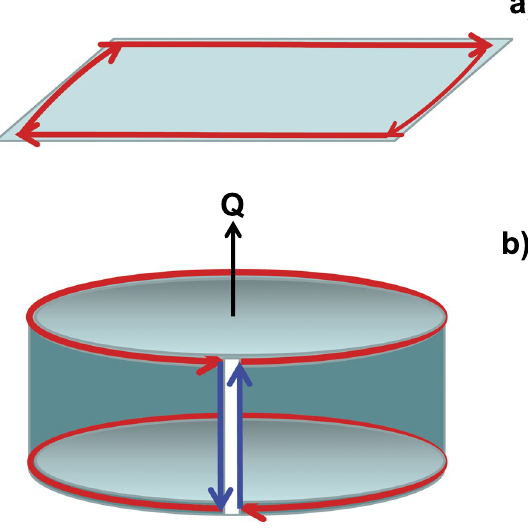
Figure 2. Sketch of the superconductor in the form of a strip on the plane ( a ), the superconductor has the spatial form of a hollow cylinder, and is pierced by a magnetic flux Q ( b ). Arrows indicate the direction of chiral current along the boundaries (red,